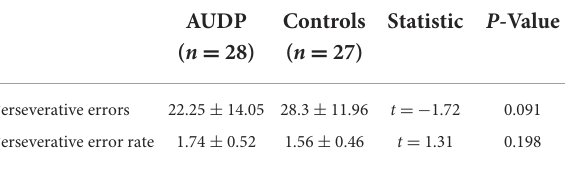
TABLE 2 Conventional behavioral measures of AUDP and healthy control